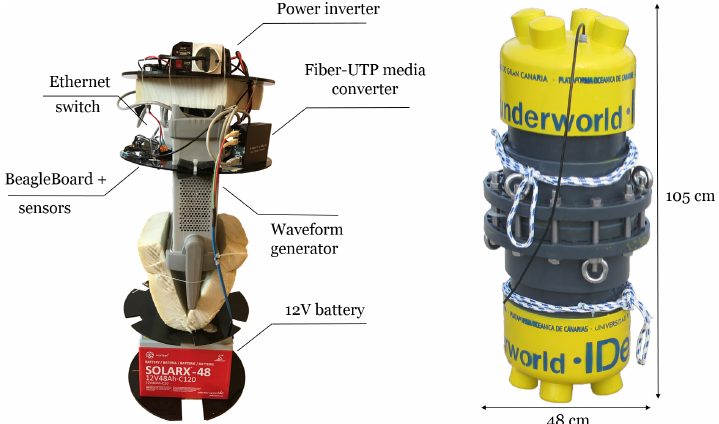
Figure 2. Transmitter chamber (the inside on the left side and the outside on the right side).